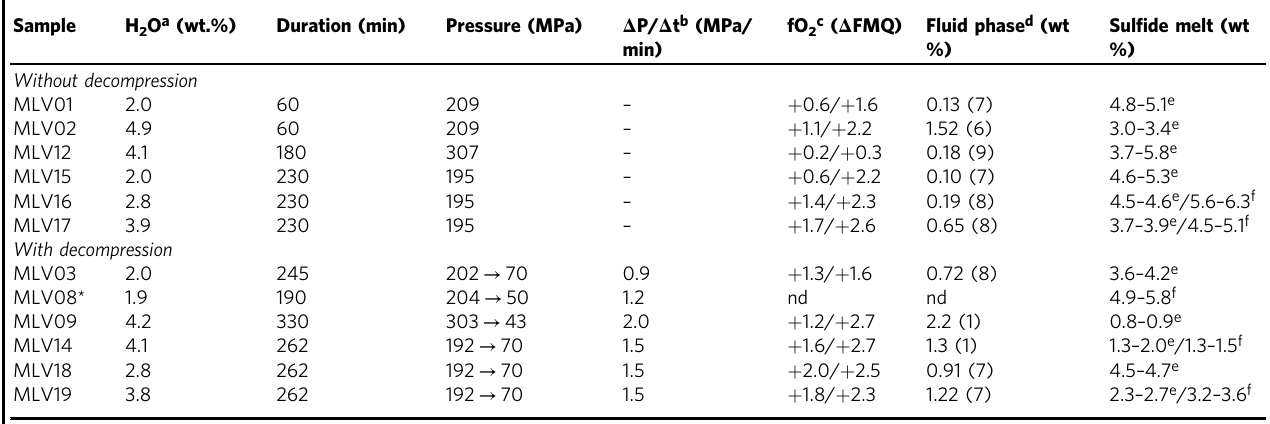
Table 1 Experimental conditions of decompression experiments.